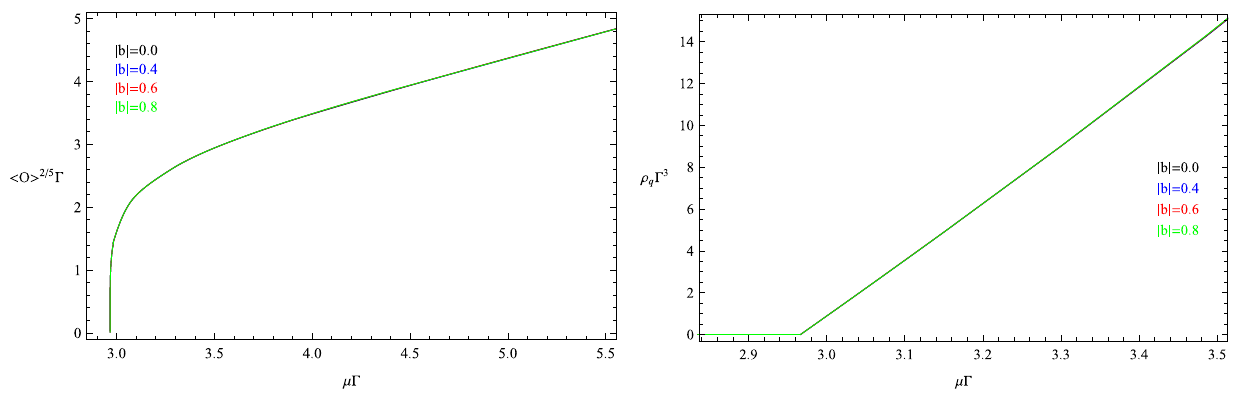
Fig. 1 The condensate of operator (cid:8) ˆ O + (cid:9) (left plot) and the charge density ρ q versus chemical potential μ for different LNE parameter b . The four curves in the left panel from button to top correspond to increasing | b | , i.e., | b | = 0.0 (black), 0.4 (blue), 0.6 (red) and 0.8 (green) respectively